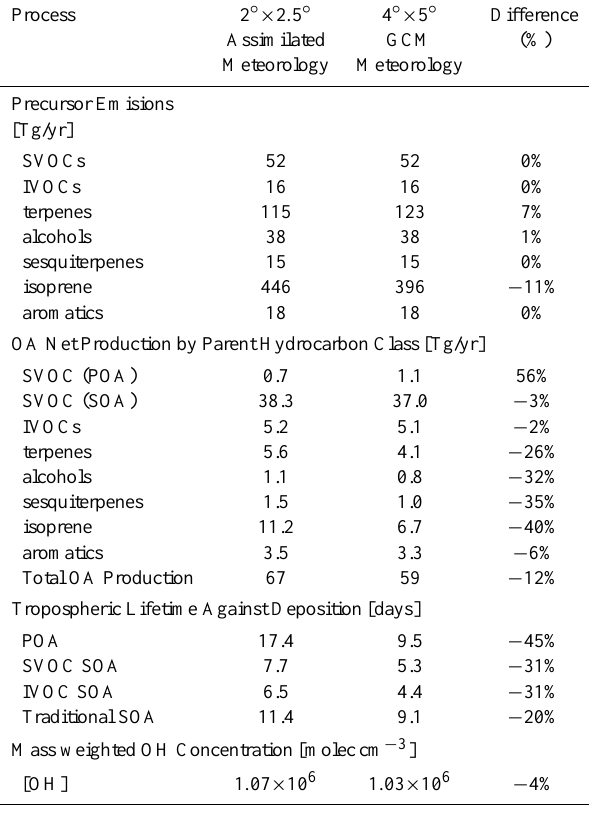
Table A1. Effect of model resolution and meteorology on global OA budget. 2 ◦ × 2 . 5 ◦ simulations are performed with GEOS-4 as- similated meteorology. 4 ◦ × 5 ◦ simulations were performed with GISS GCM Model 3 meteorology. Both simulations use revised framework (semivolatile POA, SOA from SVOCs, and SOA from IVOCs). To convert POA to TgC, divide by 1.4. To convert SOA to TgC, divide by 2.1.